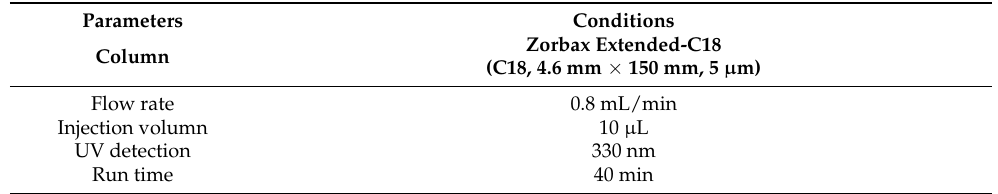
Table 7. Analytical conditions of the HPLC system for three